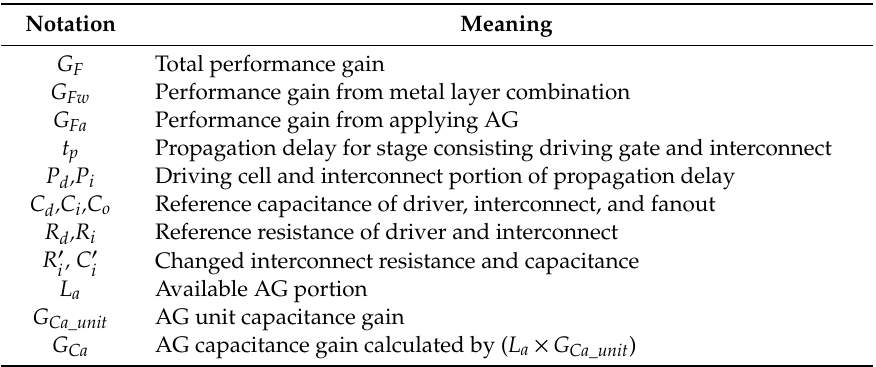
Table 1. Description of